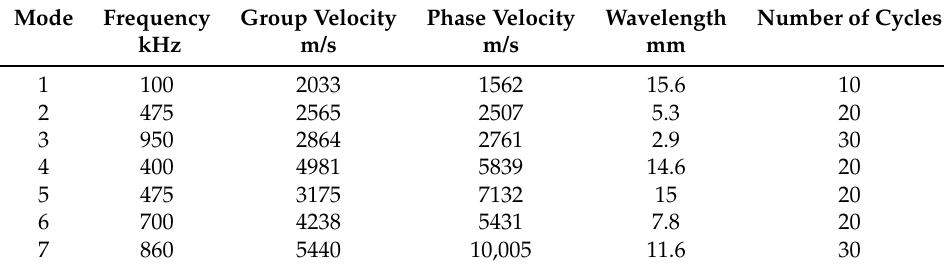
Table 3. Modes used for numerical